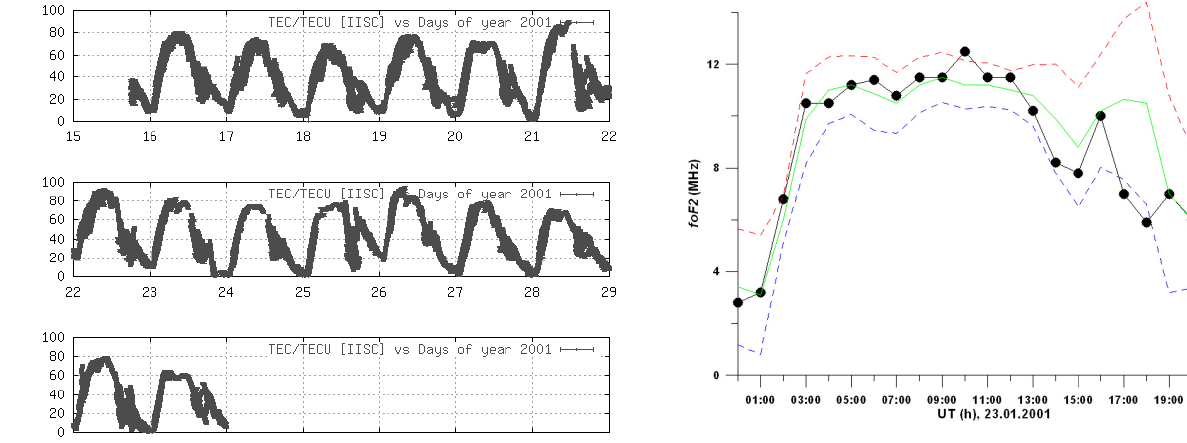
Fig. 7. foF2 variations on 23 January 2001 in a continuous line with points. In the green line, it is the monthly median, in the red dashed line it is the upper bound f oF 2 + 2 σ , and in the blue dashed line it is the lower bound f oF 2 − 2 σ